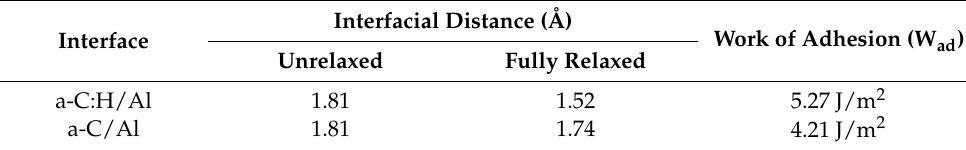
Table 2. The interfacial distance and work of adhesion.